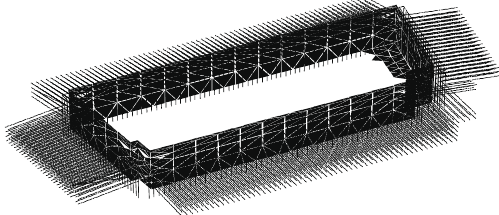
Figure 7: Lining work and prestressed cable structure